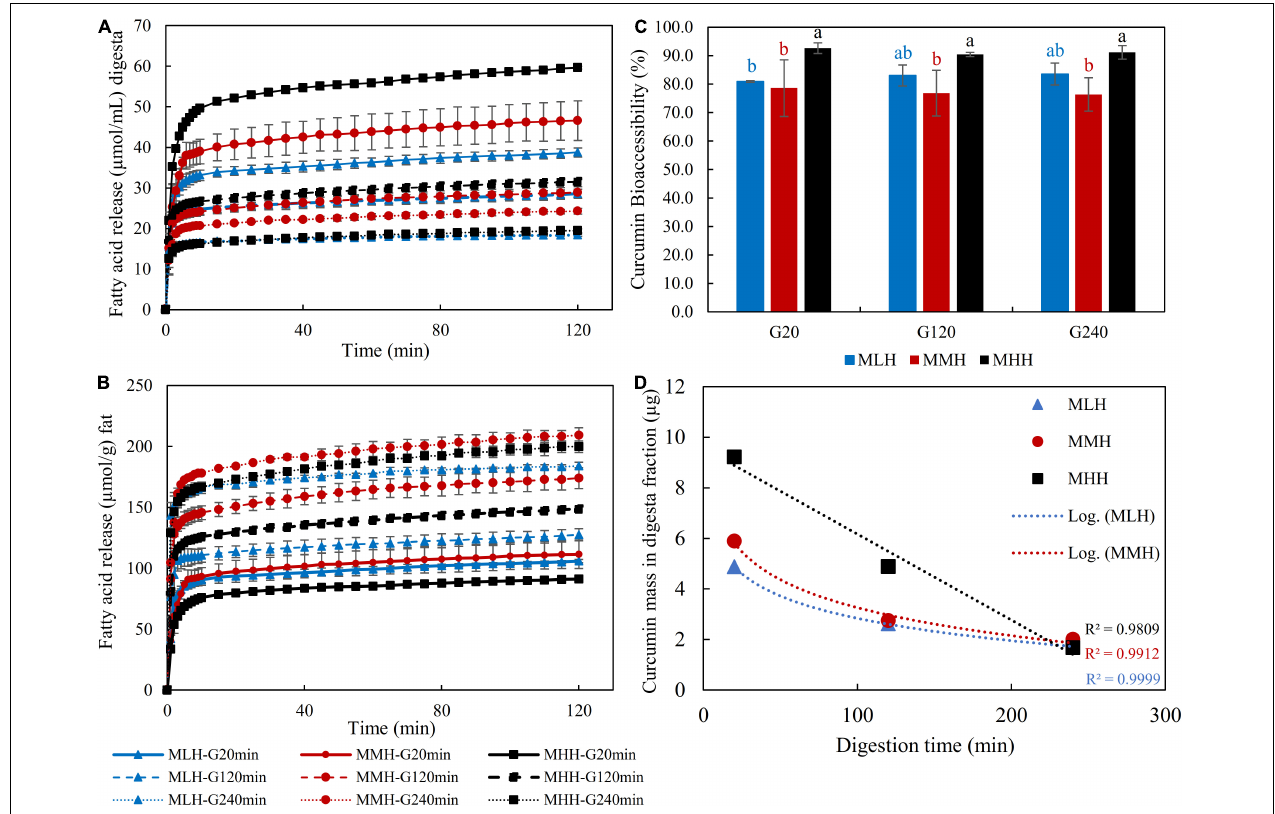
FIGURE 6 | Free fatty acid release profile (A) per milliliter of gastric digesta and (B) per gram of fat, (C) bioaccessibility of curcumin and (D) curcumin mass in digesta fractions after in vitro gastrointestinal